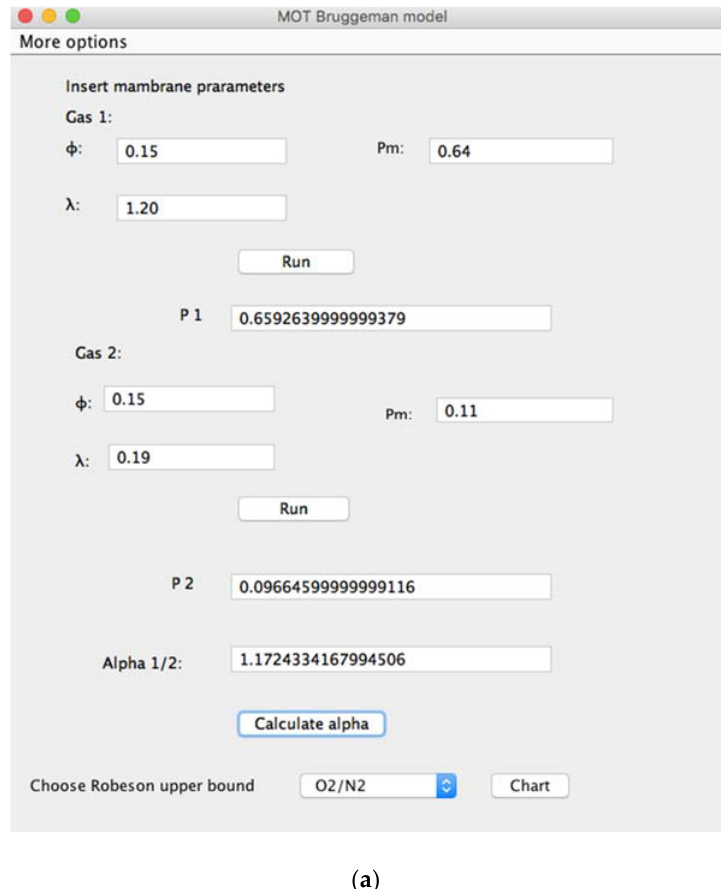
Figure 9. Dependence of the MOT predicted selectivity coefficient α O2/N2 on the oxygen permeability coefficient P for various volume fractions of zeolite 4A particles Φ in the HBPI mixed-matrix membrane relative to the Robeson upper bound line (green line).